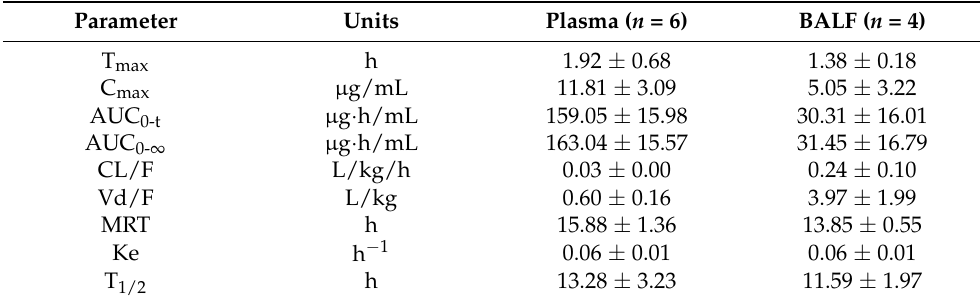
Table 3. Integration PK/PD model of CEF against P. multacia in plasma of infected pigs.